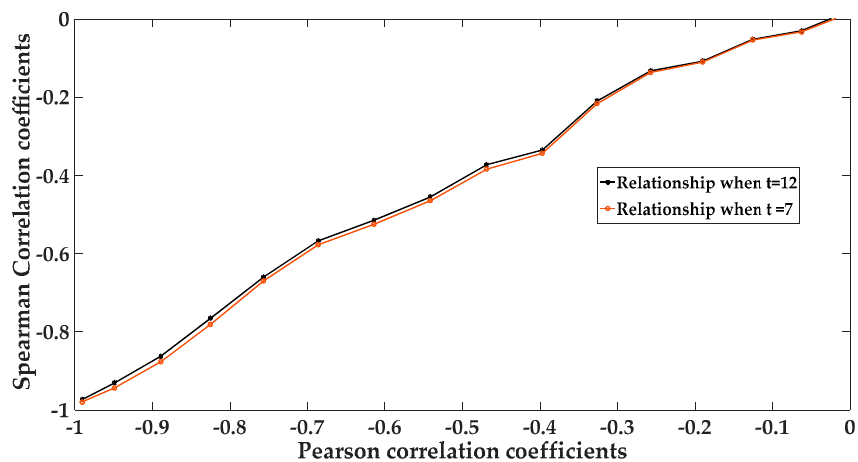
Figure 6. Relationships between Pearson correlation coefficient and Spearman correlation coefficient.